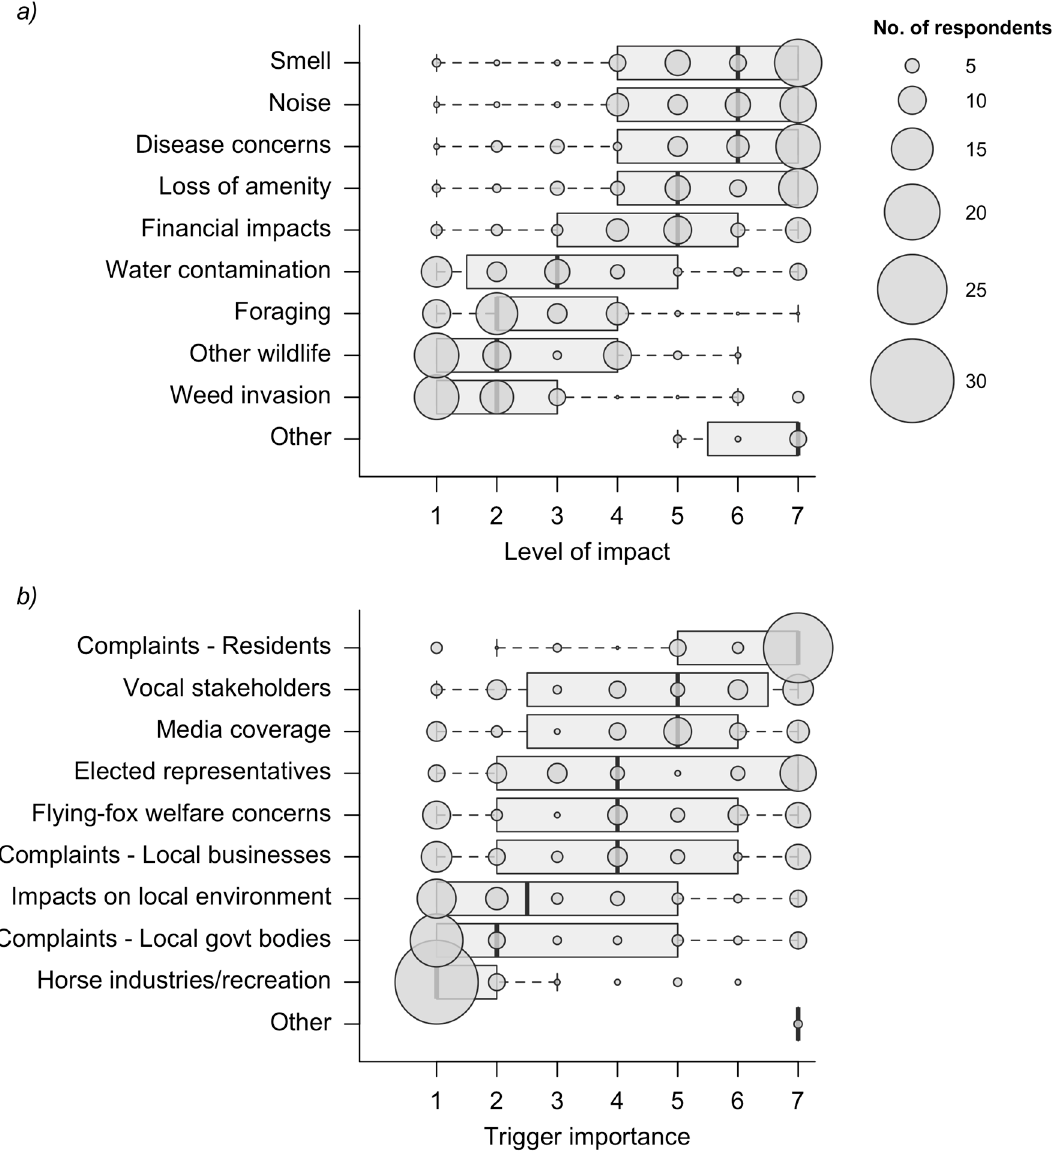
Figure 2. ( a ) Perceived degree of impact that the flying-fox camp was having on the local community and environment. Level of impact ranges from 1 = no impact, 4 = moderate impact, and 7 = serious impact. ( b ) The importance of a range of factors in triggering a decision to actively manage the flying-fox camp. Trigger importance ranges from 1 = not important, 4 = moderately important, and 7 = very important .